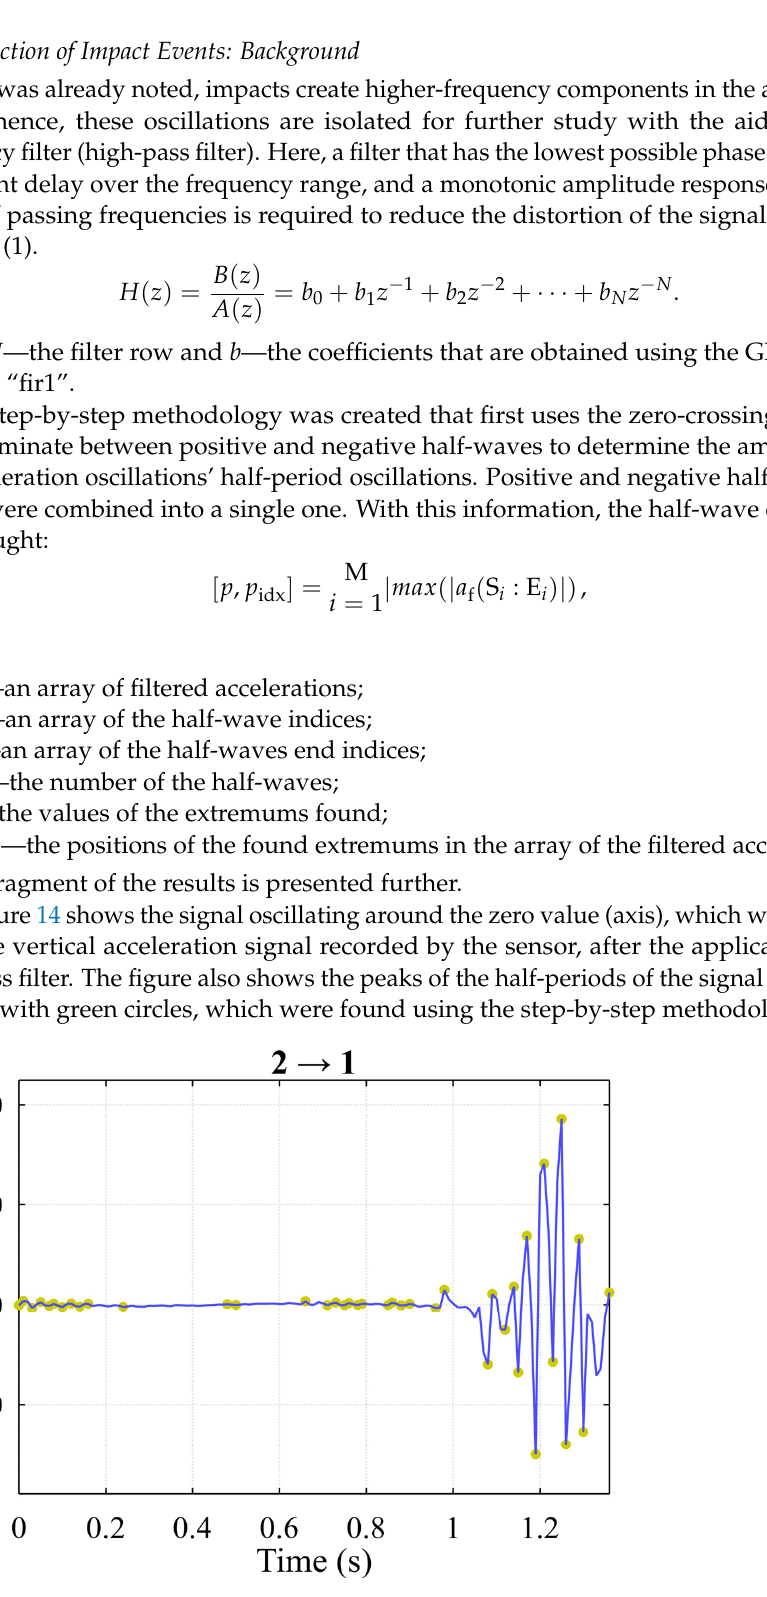
Figure 14. Peaks of acceleration